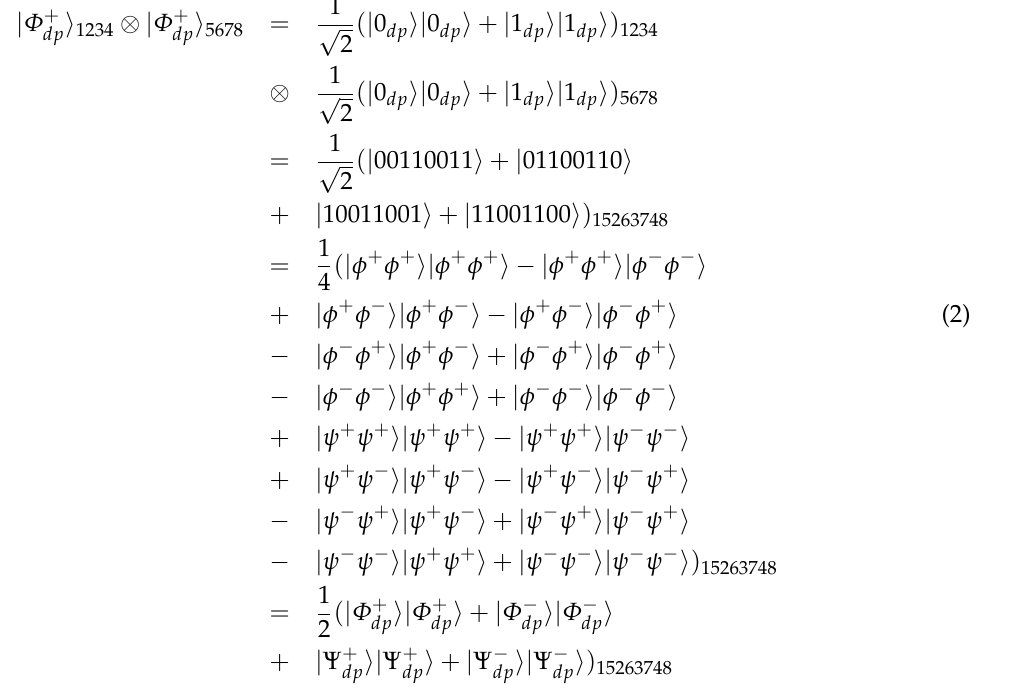
Table 1. Entanglement swapping results of arbitrary two logical Bell states under collective-dephasing noises. Two Logical Bell States Two Logical Bell States after Entanglement